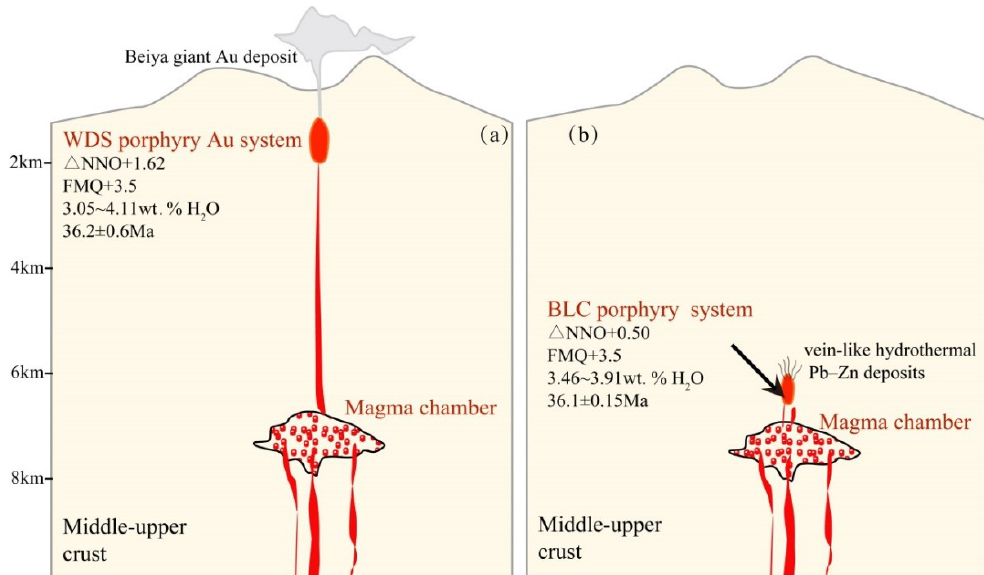
Figure 7. Cartoons illustrating the different water content, magmatic oxidation state, and emplacement depths of the parental magmas at Wandongshan ( a ) and Bailiancun ( b ), respectively. Previous studies show that the parent magma at Wandongshan ( a ) and Bailiancun ( b ) districts are derived from the same magma source [22]. This study reveals that the magma of Wandongshan experienced fluid saturation at about 1.19–2.68 km, while the magma of Wandongshan experienced fluid saturation at about 6.48–7.28 km. The water content and magmatic oxidation state of Wandongshan parental magmas are both higher than those of the Bailiancun parental magmas.